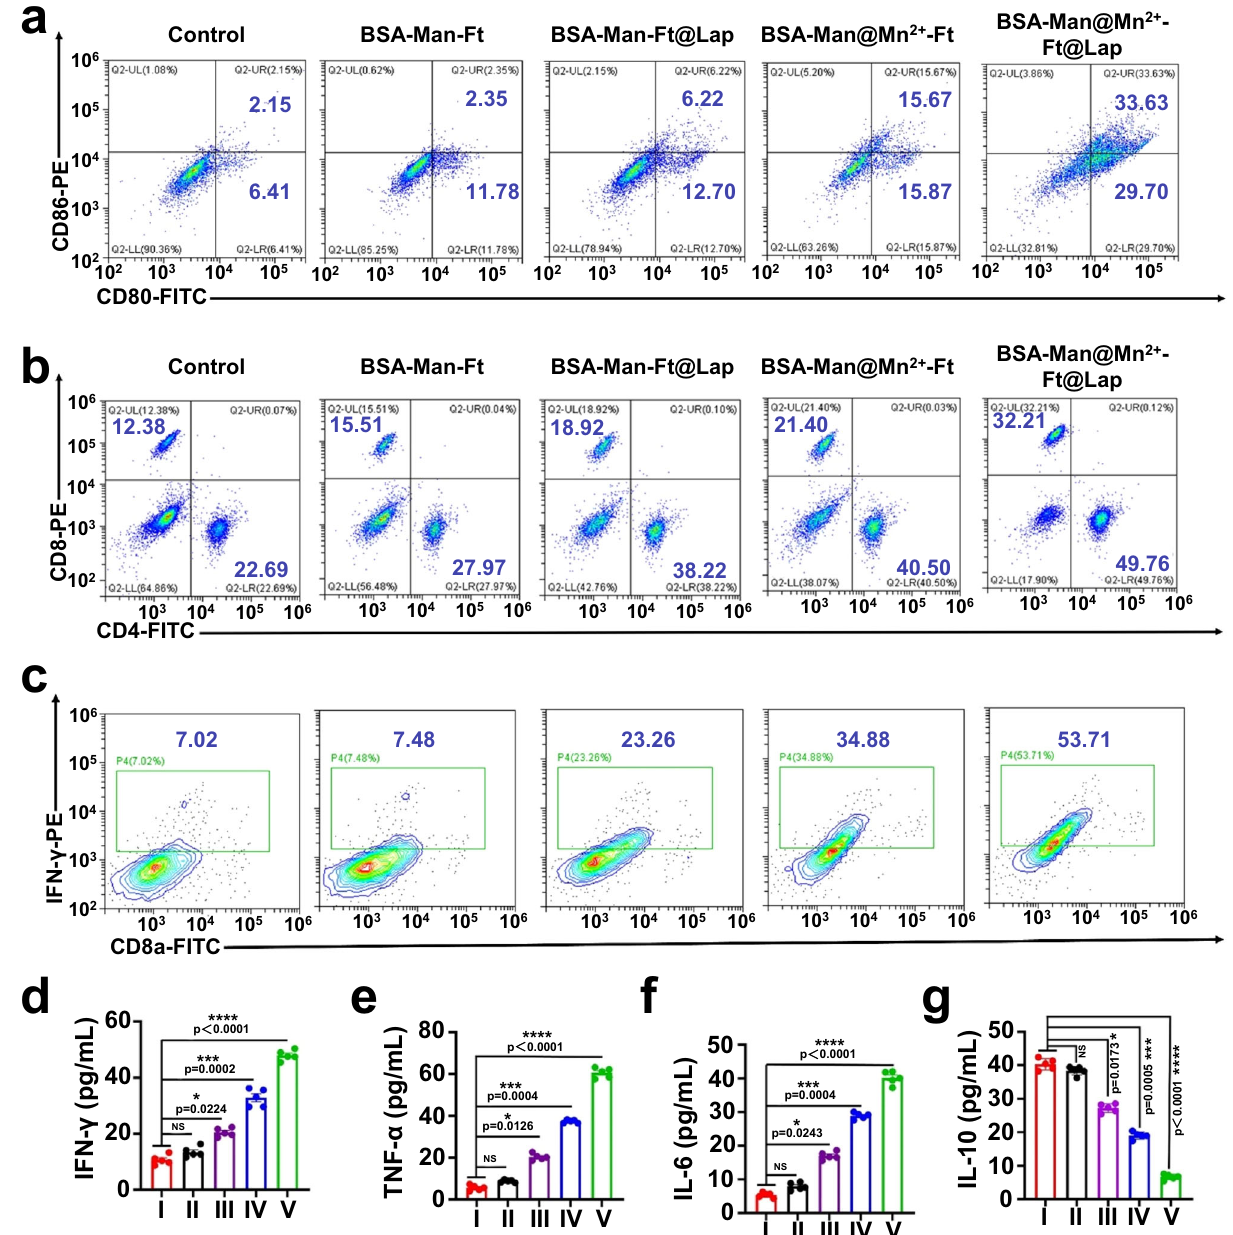
Fig. 5 | BSA-Man@Mn 2+ -Ft@Lap nanoassembly promotes DC maturation and cross-priming.a – c Flow cytometricanalysisoftheexpressionlevelsofmatureDC markers CD80/CD86 and effector T cell markers CD4/CD8 and CD8a/ IFN- γ in splenic immune cells co-incubated with 4T1 cells treated with: (I) control, (II) BSA- Man-Ft, (III) BSA-Man-Ft@Lap, (IV) BSA-Man@Mn 2+ -Ft, or (V) BSA-Man@Mn 2+ - Ft@Lap for 24h; fl ow cytometry experiments in panels a – c were repeated three times independently with similar results. d – g Secretion levels of immunostimula- tory cytokines including IFN- γ , TNF- α , IL-6, and IL-10 in the supernatant from the